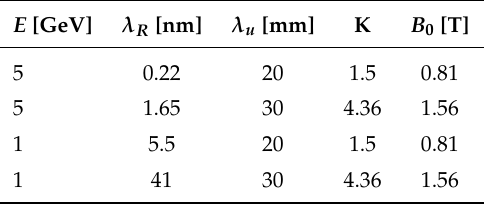
Table 2. Undulator configurations used for the free-electron laser (FEL) environment.